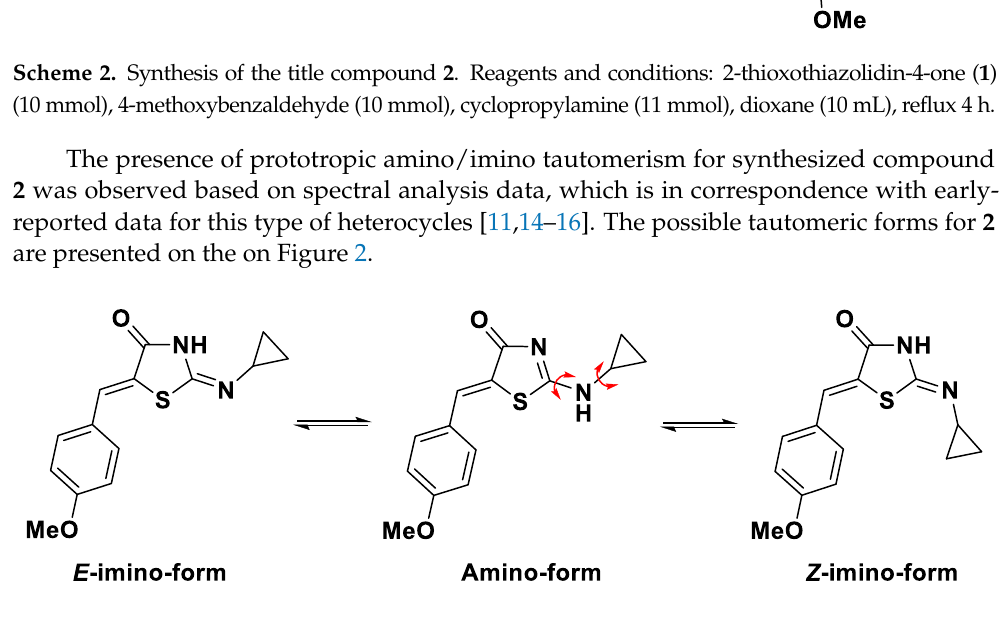
Figure 2. Possible tautomeric forms for title compound 2 .